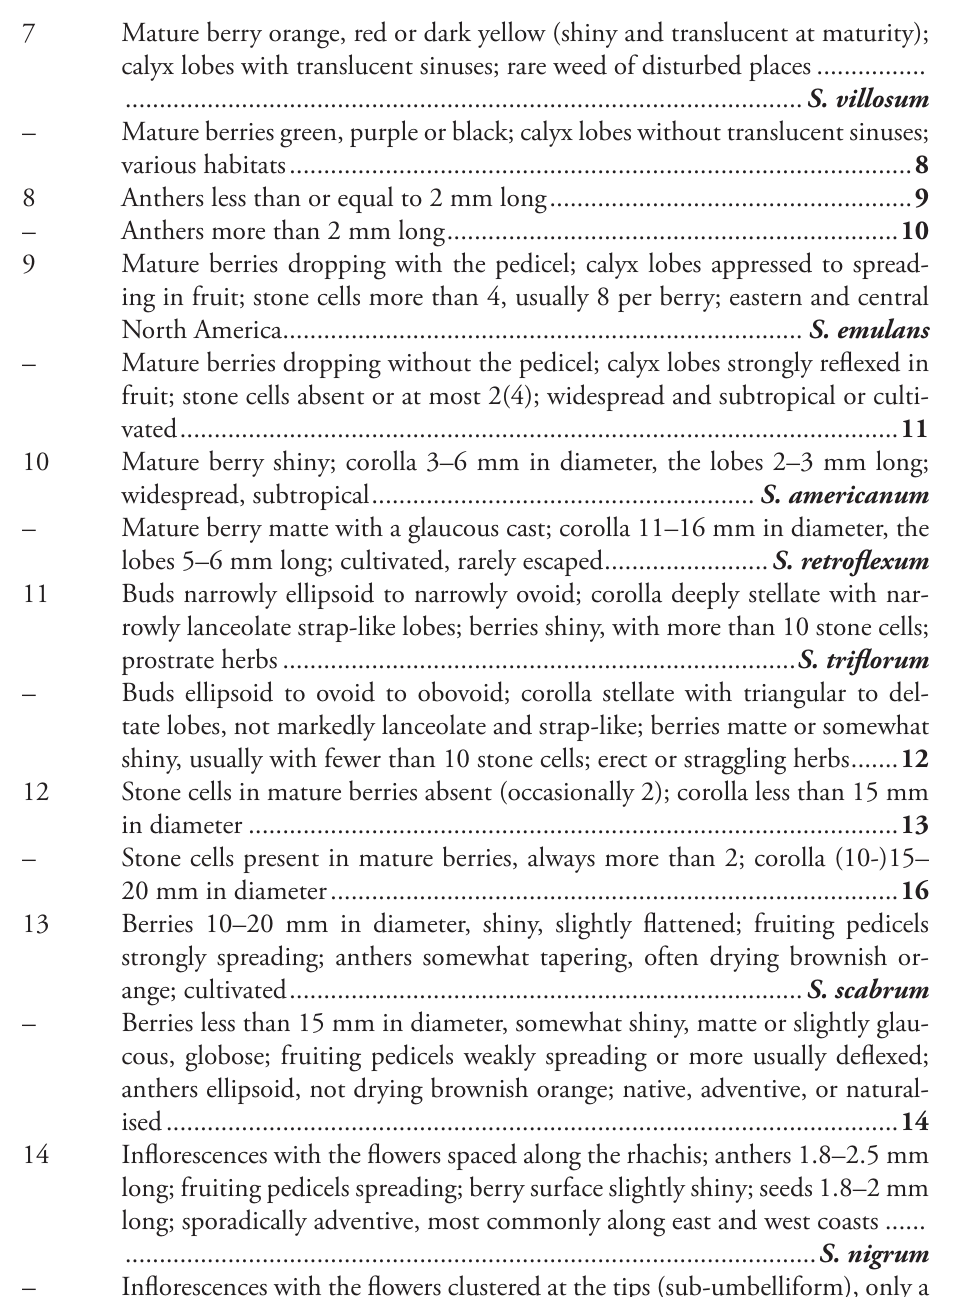
Mature berry orange, red or dark yellow (shiny and translucent at maturity);